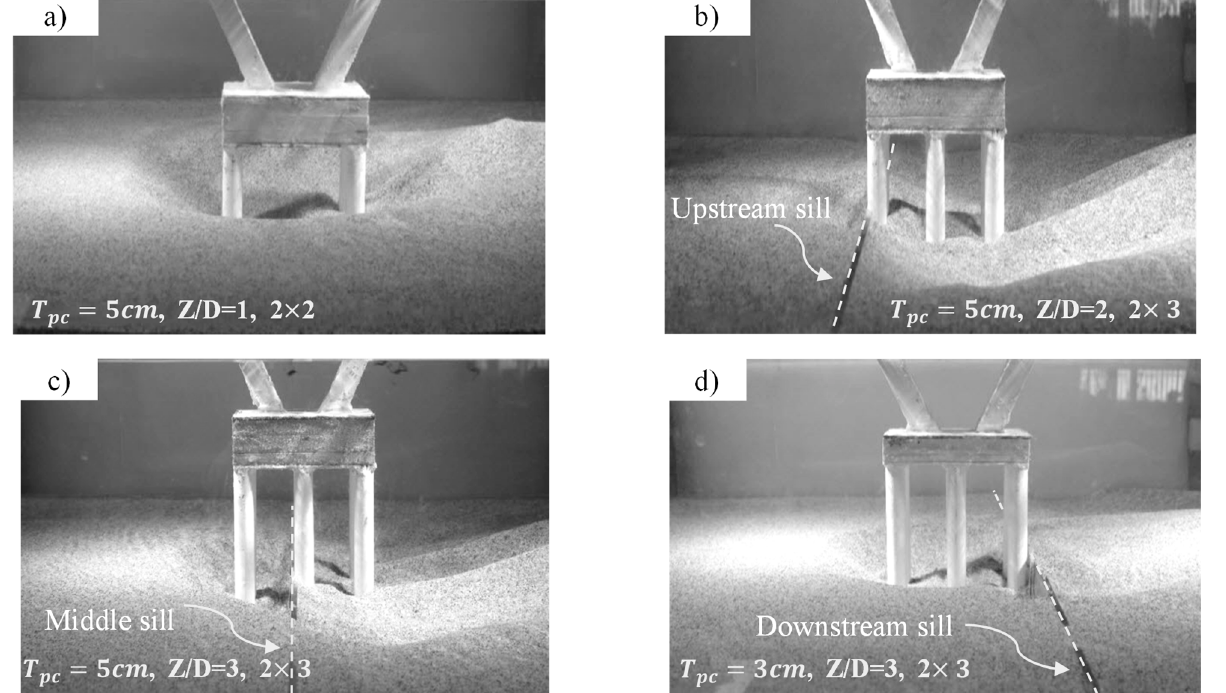
Figure 6. Sample arrangement of the pier components in different experiments: ( a ) no sill, ( b ) upstream sill ( X s = 0), ( c ) middle sill ( X s = 0.5), and ( d ) downstream sill ( X s = 1). The arrangements of the piles beneath the cap are furnished as n × m .